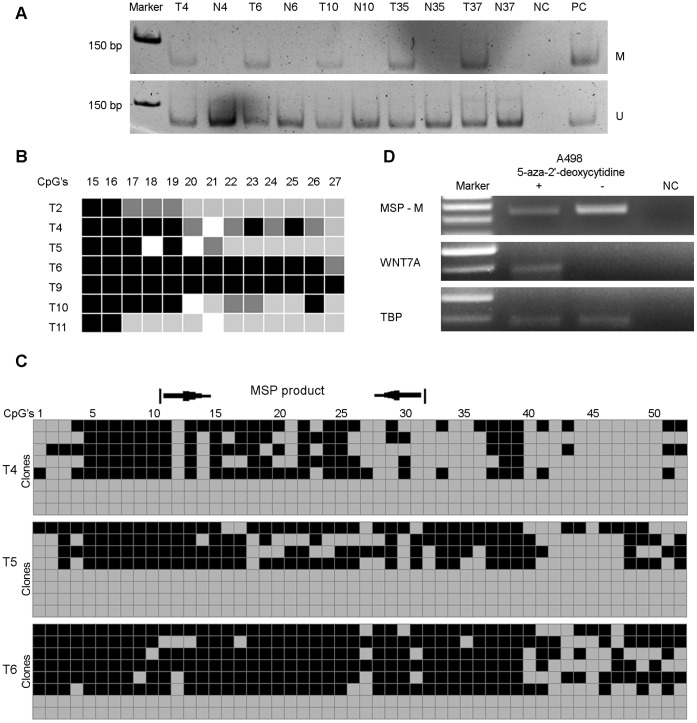
Study of WNT7A gene methylation status in clear cell RCC.(A). Representative MSP analysis of the WNT7A gene by using methylated (M) and unmethylated (U) specific primers, PC – positive control, M.Sssi treated or untreated normal DNA, NC – negative control (H20), T4, T6, T10, T35, T37: tumor samples, N4, N6, N10, N35, N37: normal samples. (B). Sequencing of MSP products; white squares - 0–19% methylation at the CpG dinucleotide, grey squares - 20–59% methylation at the CpG dinucleotide, dark grey squares - 60–79% methylation at the CpG dinucleotide, black squares - 80–100% methylation at the CpG dinucleotide, T2, T4, T5, T6, T9, T10, T11: tumor samples. (C). Methylation status of the fifty two CpG dinucleotides of the WNT7A 5′-CpG island in tumor samples with a methylated WNT7A gene, where each CpG dinucleotide is shown by either a black square when methylated or a grey square when unmethylated; arrows indicate position of MSP primers, T4, T5, T6 are tumor samples. (D). Restoration of WNT7A expression by 5-aza-2′-deoxycytidine treatment of the A498 cell line, MSP-M - methylation analysis of the WNT7A gene by using methylated specific primers, NC – negative control (H20).